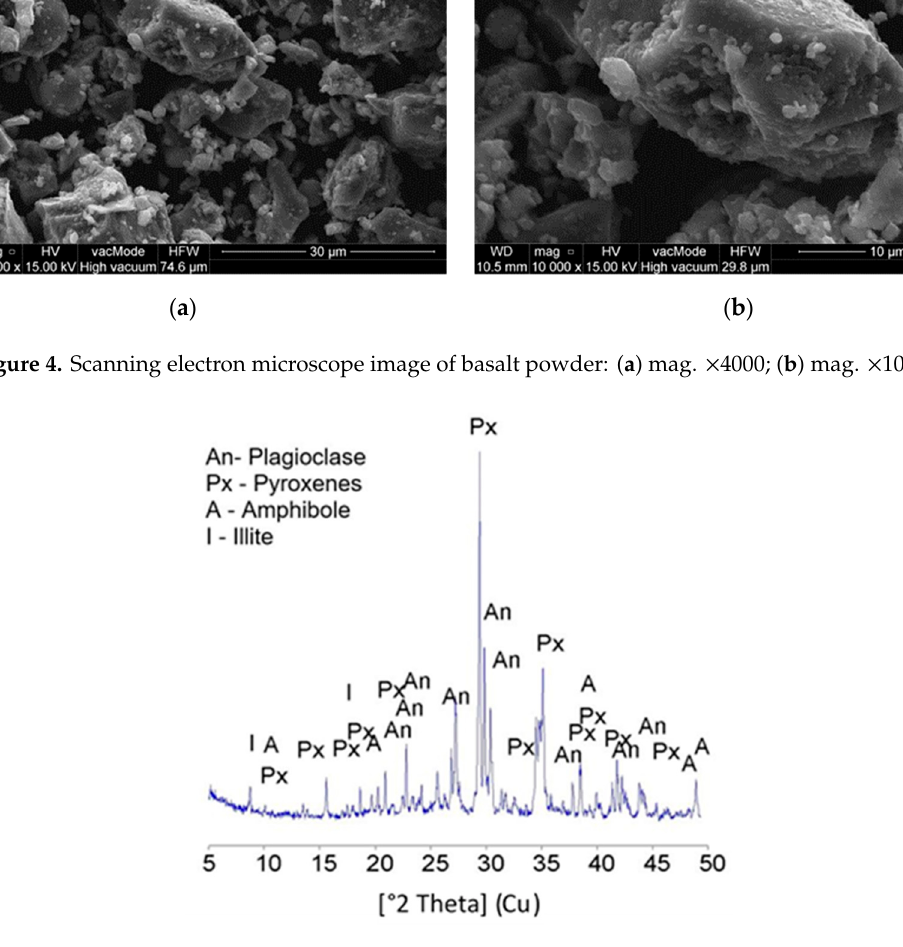
Figure 5. XRD diffractogram of the basalt powder.